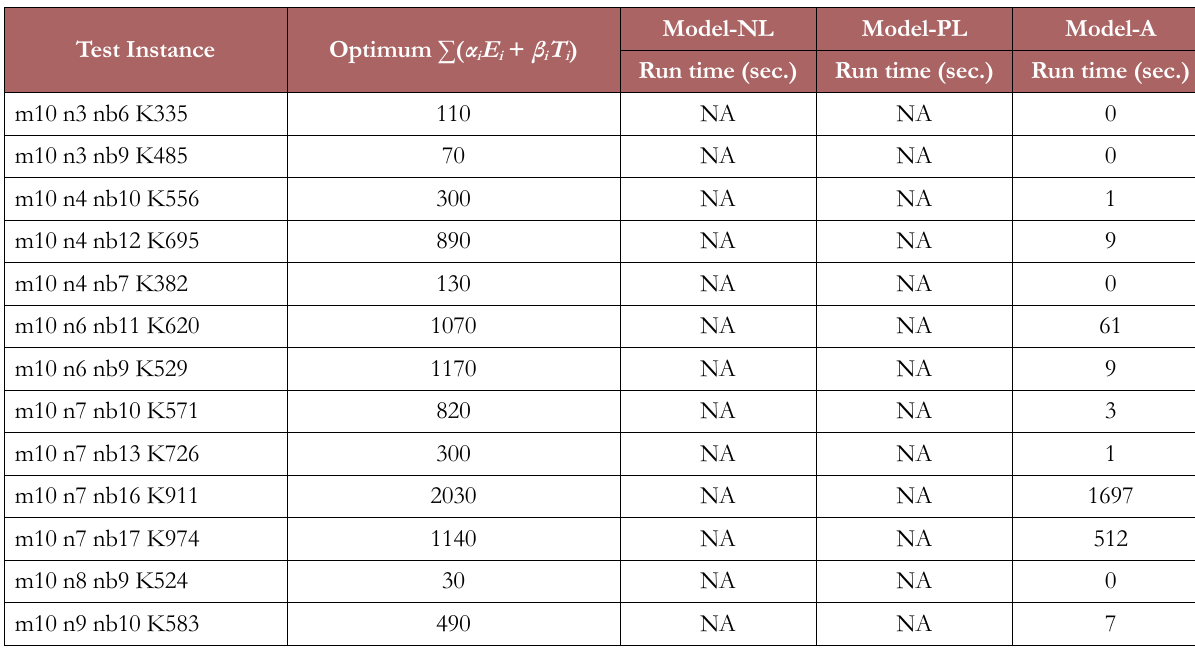
Table A1. Results obtained from Model-NL, Model-PL, and Model-A on the test instances